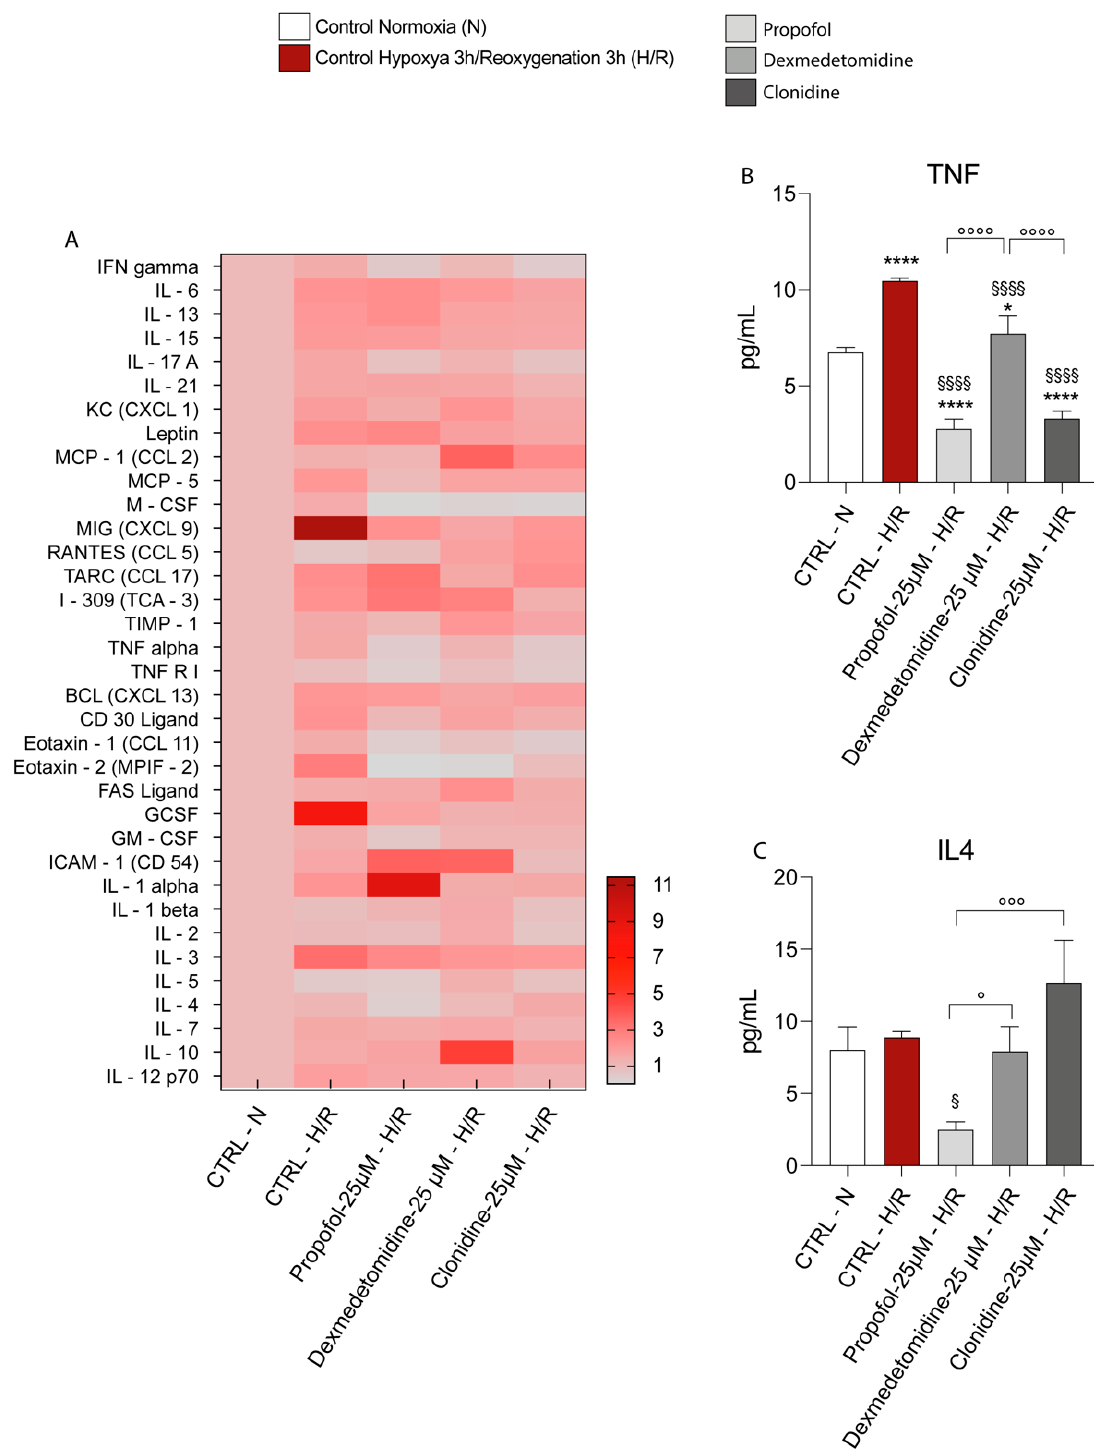
Figure 5. ( A ) Heatmap representing the levels of major cytokines and chemokines detected Cytokine antibody arrays. ( B ) TNF, ( C ) IL4 levels. Results are presented as the mean ± SD of four independent experiments. * vs. CTRL Normoxia (* p < 0.05; **** p < 0.0001); § vs. CTRL Hypoxia/Reoxygenation. ( § p < 0.05; §§§§ p < 0.0001); ° vs. the different drugs (propofol vs. dexmedetomidine; propofol vs. clonidine; dexmedetomidine vs. clonidine) (° p < 0.05; °°° p < 0.001; °°°° p < 0.0001).